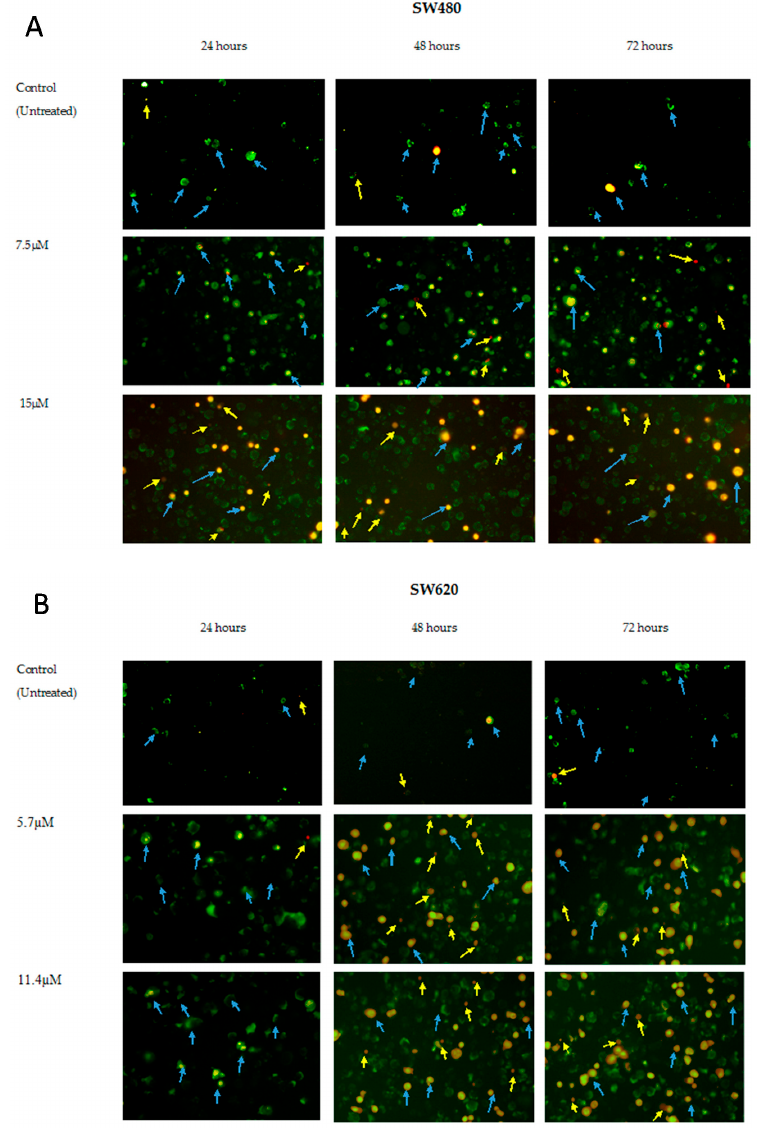
Figure 5. MS13 induces cell death as observed by apoptotic morphological changes in ( A ) SW480 ( B ) SW620 human colon cancer cells. Detection was by fluorescence microscopy of Annexin V / PI treated with MS13 for 24, 48 and 72 h at 200 × magnification. Viable cells (Annexin V- / PI-) are invisible; Early apoptotic cells showed green plasma membrane (Annex-V +/ PI-); Late apoptotic cells showed red staining throughout the nucleus with halo of green on plasma membrane indicating loss of membrane integrity (Annex-V +/ PI + ), chromatin condensation and fragmentation, stained green to yellow (Annex-V +/ PI + ), yellow-orange and orange (Annex-V +/ PI + ) (arrow in blue); necrotic cells (Annex-V- / PI + ) showed uniformly red or pale orange (arrow in